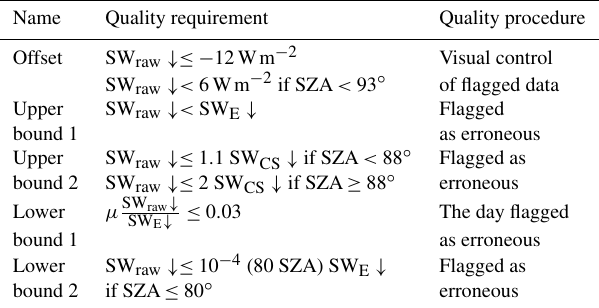
Table 2. An overview of the automatic quality control tests, based on the relative values of the solar zenith angle (SZA), measured (SW raw ↓ ), extraterrestrial (SW E ↓ ), and clear-sky (SW CS ↓ ) inci- dent global radiation. The table is adapted from Table 4.1.1 in Grini